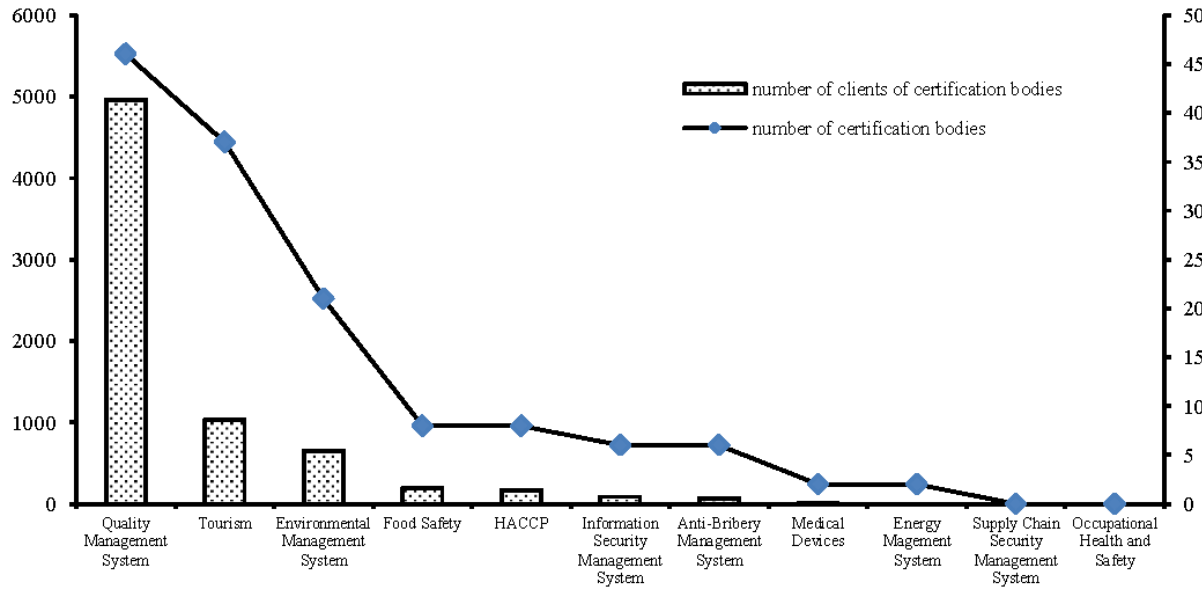
Figure 4: Profile of system certification bodies in Indonesia